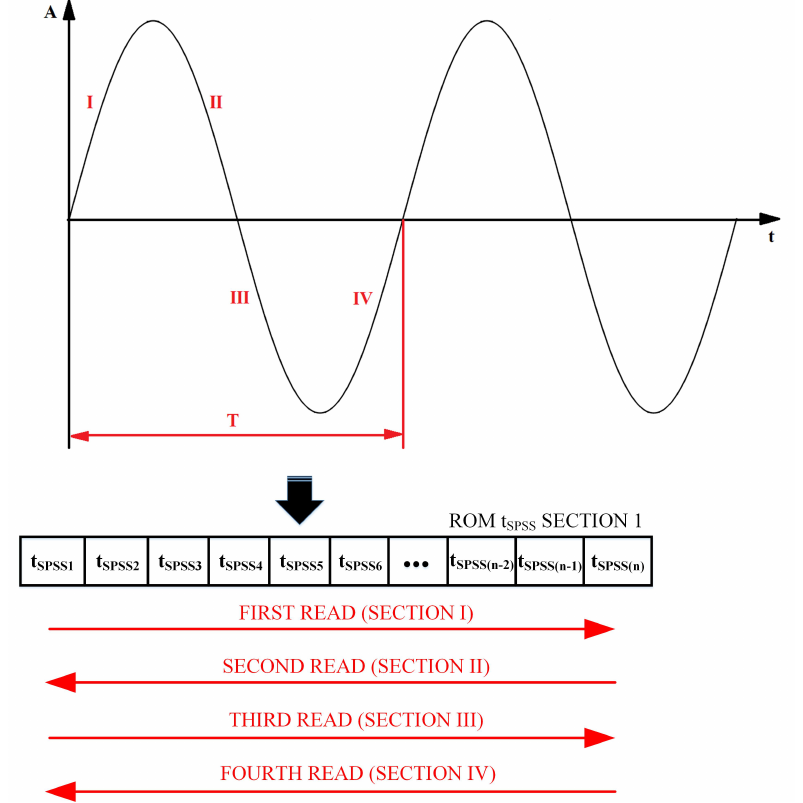
Figure 11. Reading procedure for the SPSS ROM.